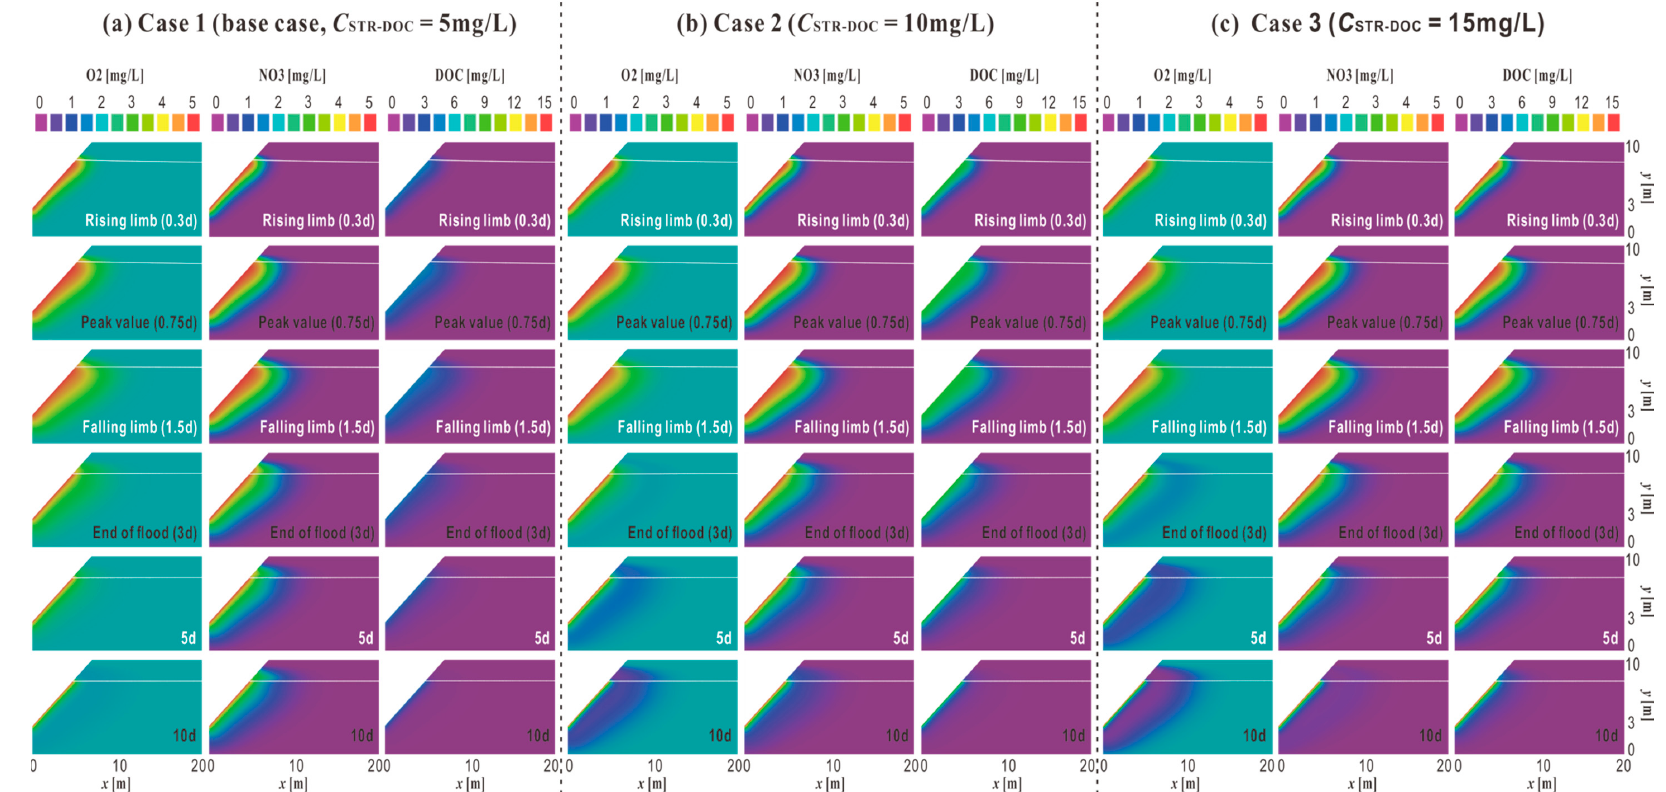
Figure 3. The effect of surface water dissolved organic carbon (DOC) concentration on riparian nitrogen cycle driven by water level fluctuation. The white lines represent groundwater levels. C STR-DOC denotes the DOC concentration of surface water.